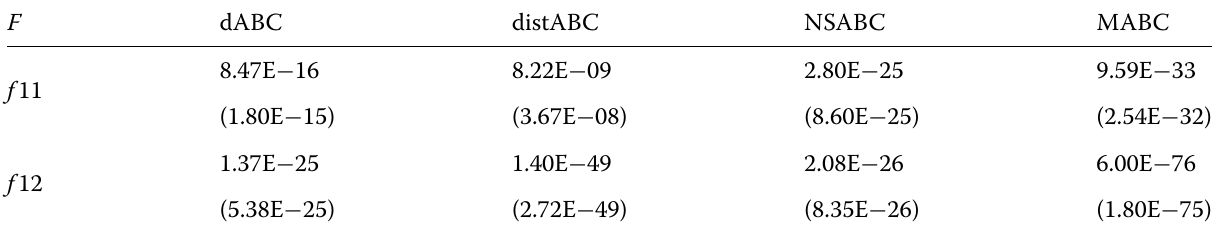
Table 10 Comparison results (2), D =